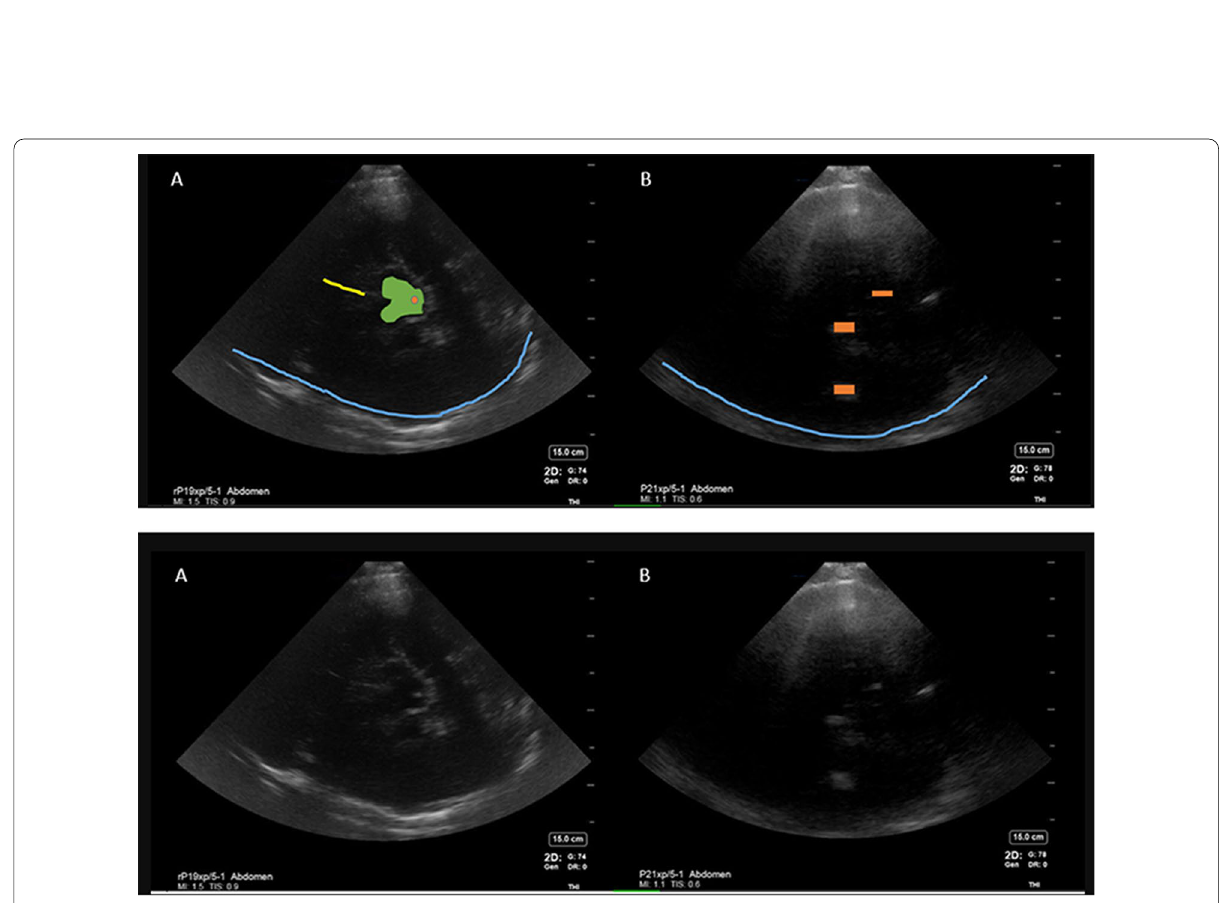
Fig. 2 Abdominal presets showing the cerebral aqueduct and choroid plexus on cranial B mode imaging. Upper panel shows abdominal presets with markings labelled as followed: Blue line —opposite skull, green —midbrain, orange dot inside the midbrain—cerebral aqueduct, yellow line —falx cerebri, orange rectangles—choroid plexus calcification in lateral ventricles. Lower panel shows unlabeled images of abdominal